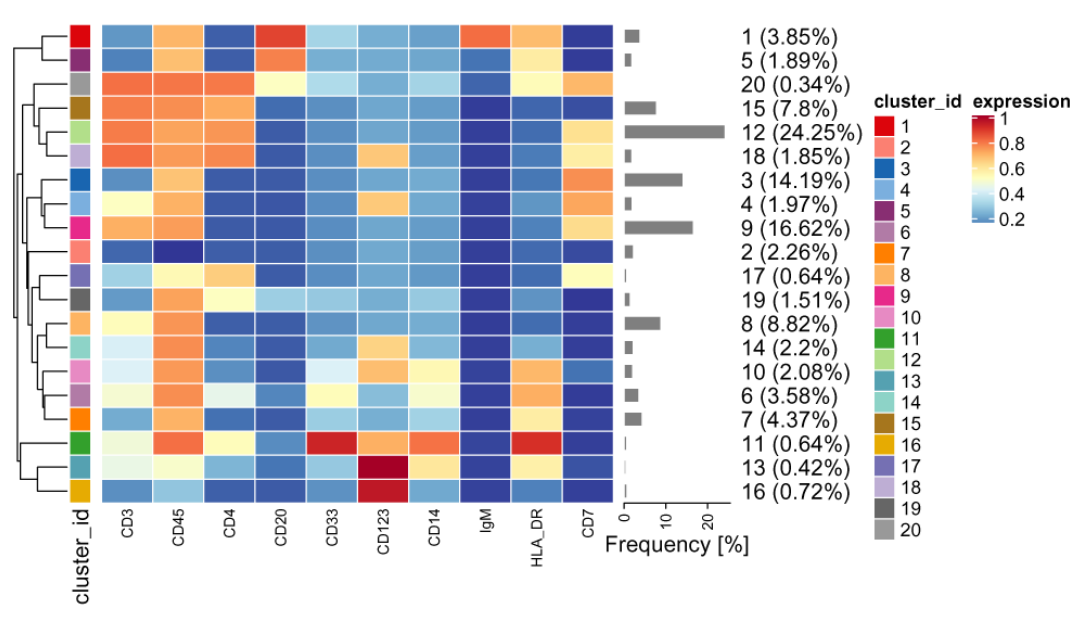
Figure 6. Heatmap of the median marker intensities of the 10 lineage markers across the 20 cell populations obtained with FlowSOM after the metaclustering step with ConsensusClusterPlus (PBMC data). The color in the heatmap represents the median of the arcsinh, 0-1 transformed marker expression calculated over cells from all the samples, varying from blue for lower expression to red for higher expression. The dendrogram on the left represents the hierarchical similarity between the 20 metaclusters (metric: Euclidean distance; linkage: average). Each cluster has a unique color assigned (bar on the left) which is identical in other visualizations of these 20 clusters (e.g., the